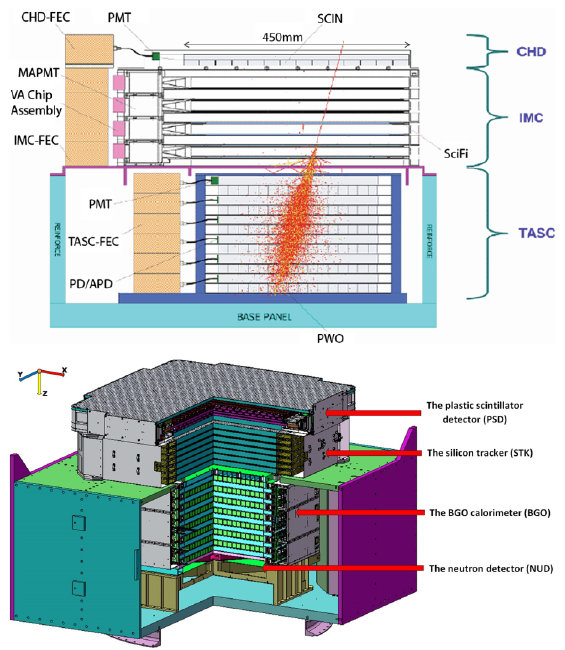
Figure 2. Schemes of the CALET [9] (top image) and DAMPE [8] (bottom image) detectors.